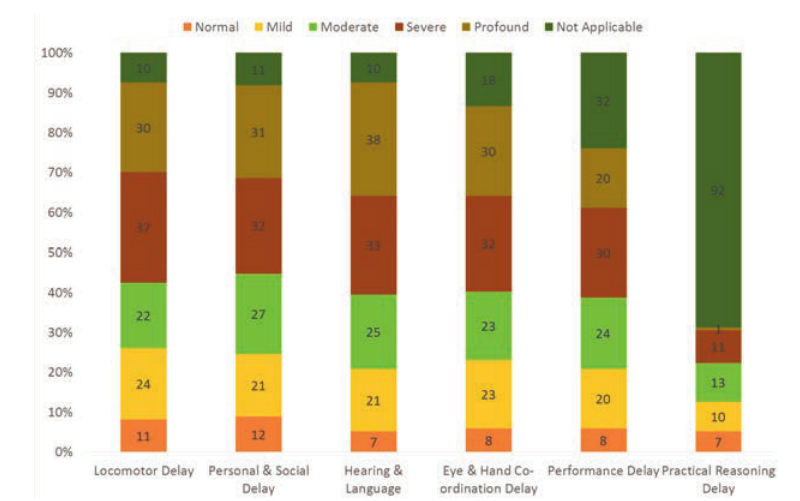
Figure 4. Number of cases diagnosis by epilepsy.